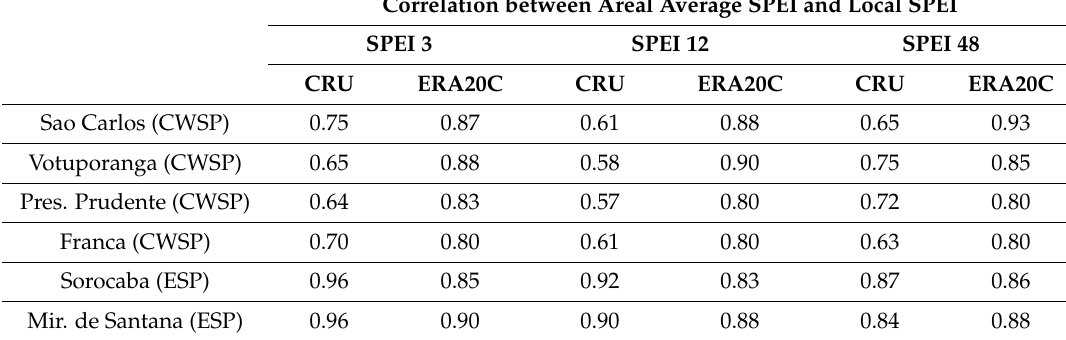
Table 4. Spearman correlation coefficient between areal average SPEI in CWSP/ESP and SPEI calculated from time series in different single points inside the